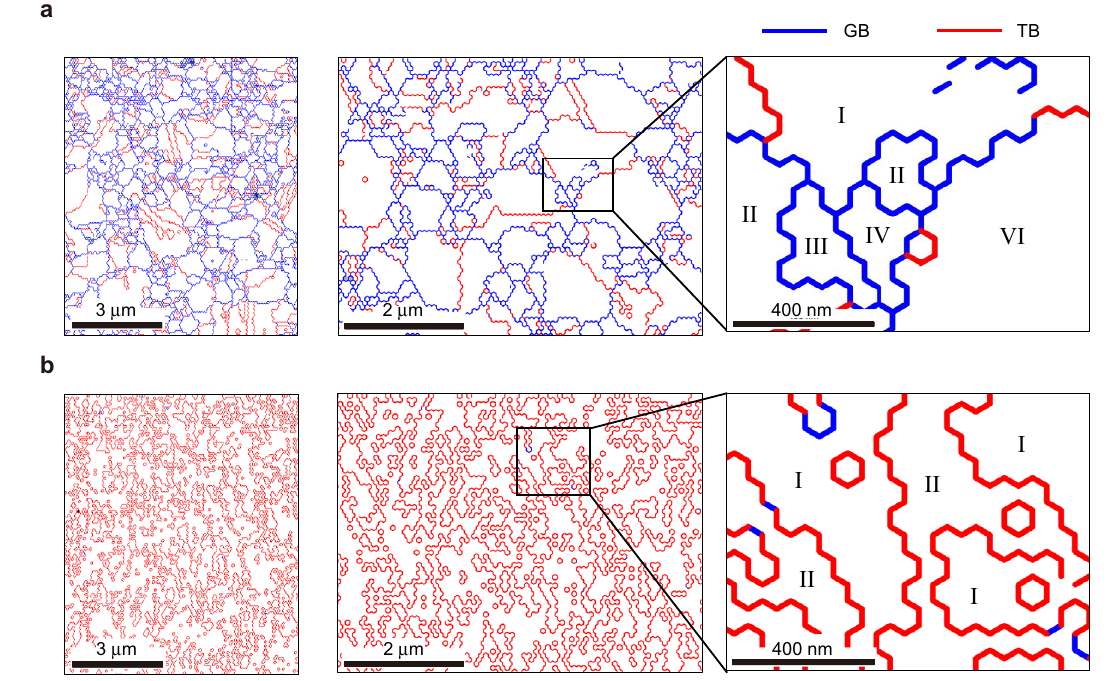
Fig. 4 | Grain boundaries (GBs) and twin boundaries (TBs). a Misorientation line distributions for a polycrystalline fi lm. Red and blue lines denote TBs and GBs. Regions in the magni fi ed image (third column) have various orientations (ORs). b Misorientation line distributions for a single-crystal Cu fi lm. Misorientation lines are composed mostly of TBs. There are one of two ORs in the regions in the magni fi ed image in the third column. The two regions separated by GBs in